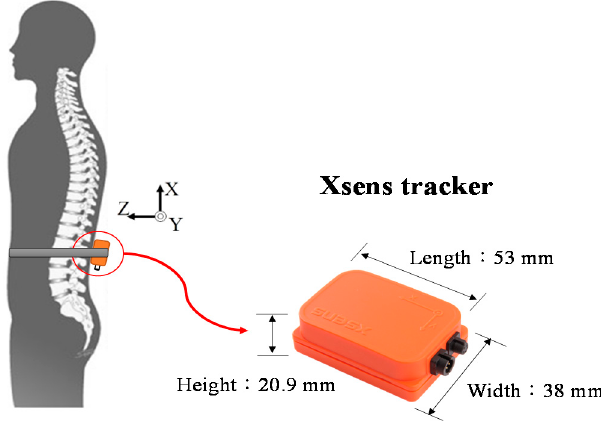
Figure 2. Xsens tracker and its position.